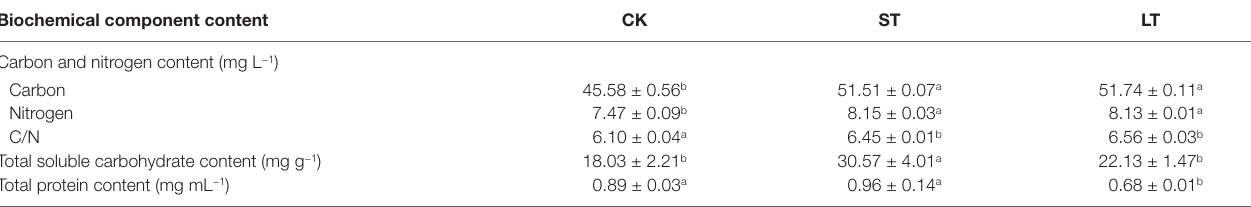
TABLE 2 | Biochemical components of N. oceanica when subjected to different treatments. Biochemical component content